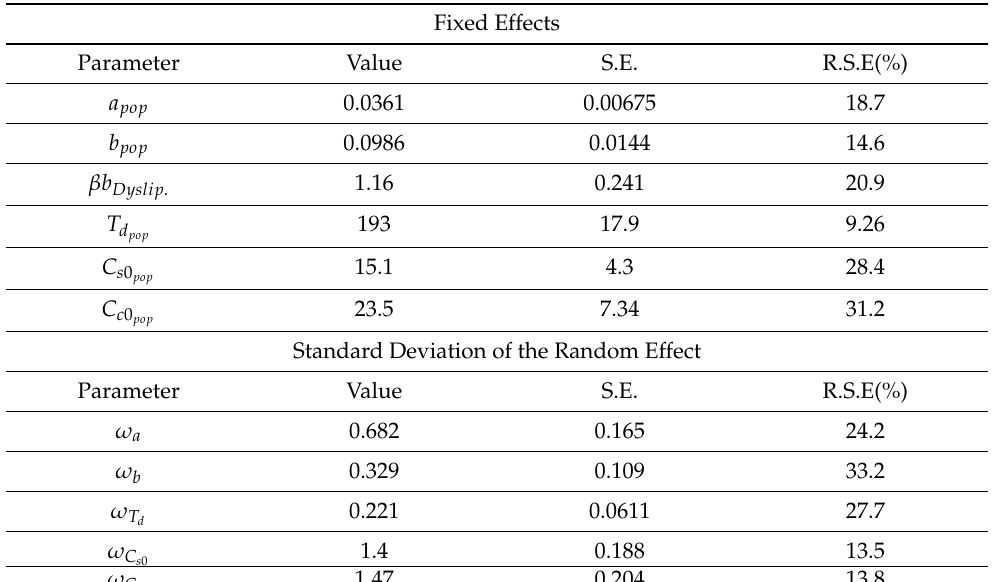
Table 3. Fixed and random effects estimated for each parameter. S.E. and R.S.E (%) are reported for both